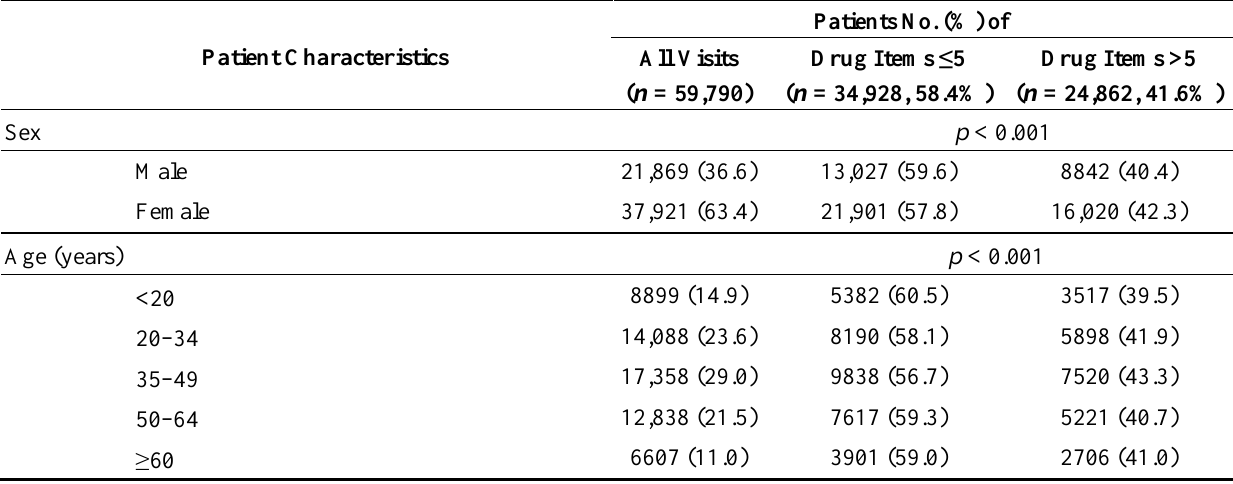
Table 7. Characteristics of patients taking ≤5 and >5 Chinese herbal medicine (CHM) drugs in a single prescription in